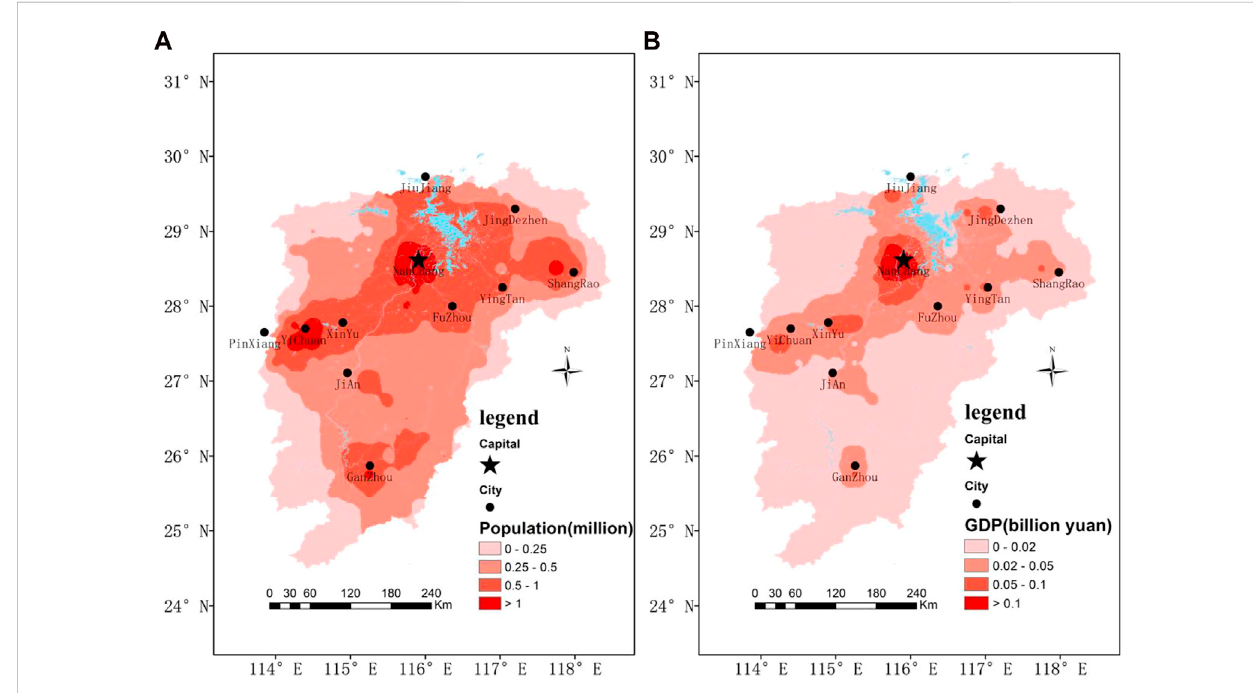
Spatial distribution of average annual change in (A) population exposure and (B) GDP exposure to extreme precipitation events in the Poyang Lake Basin (1984 – 2020).